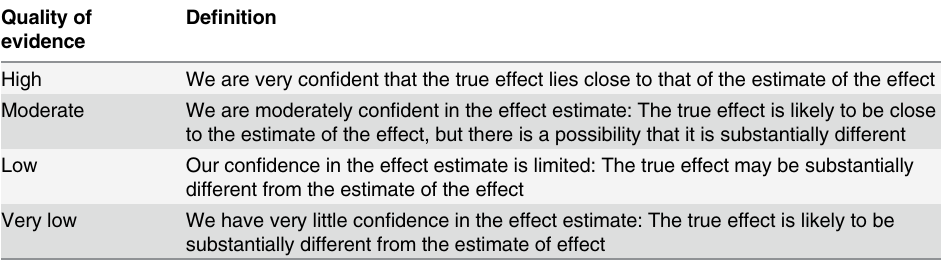
Primary outcomes were: treatment effects, number of complications/side effects. Secondary outcomes were: QoL. Table 3. GRADE analysis and